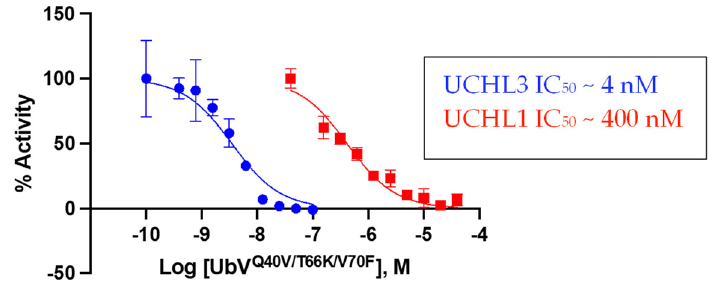
plotted for UCHL3 (blue) and UCHL1